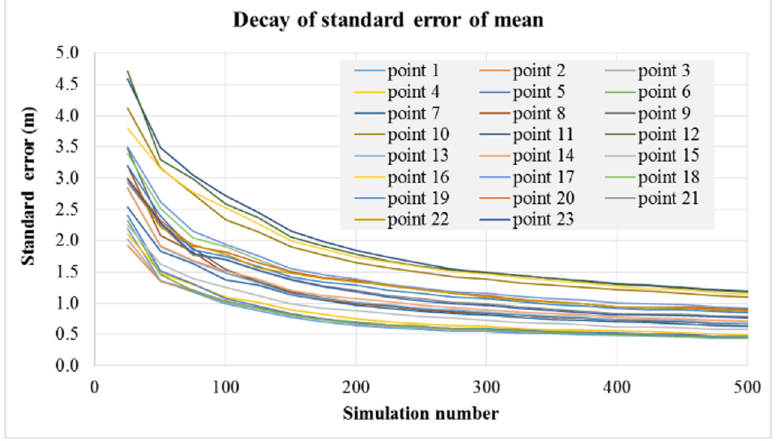
Figure 16. Standard error of mean of groundwater head at 23 locations for different sample sizes.